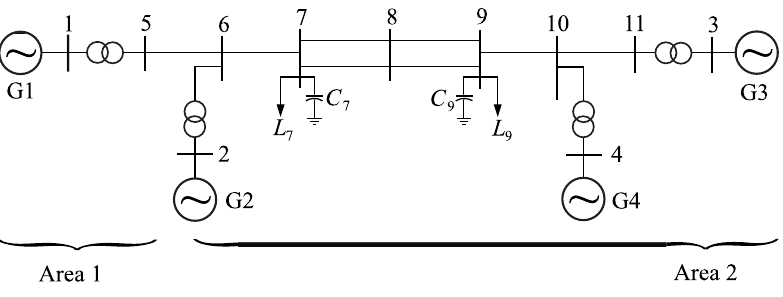
Figure 7. 11-bus test system [26] with areas defined by the proposed